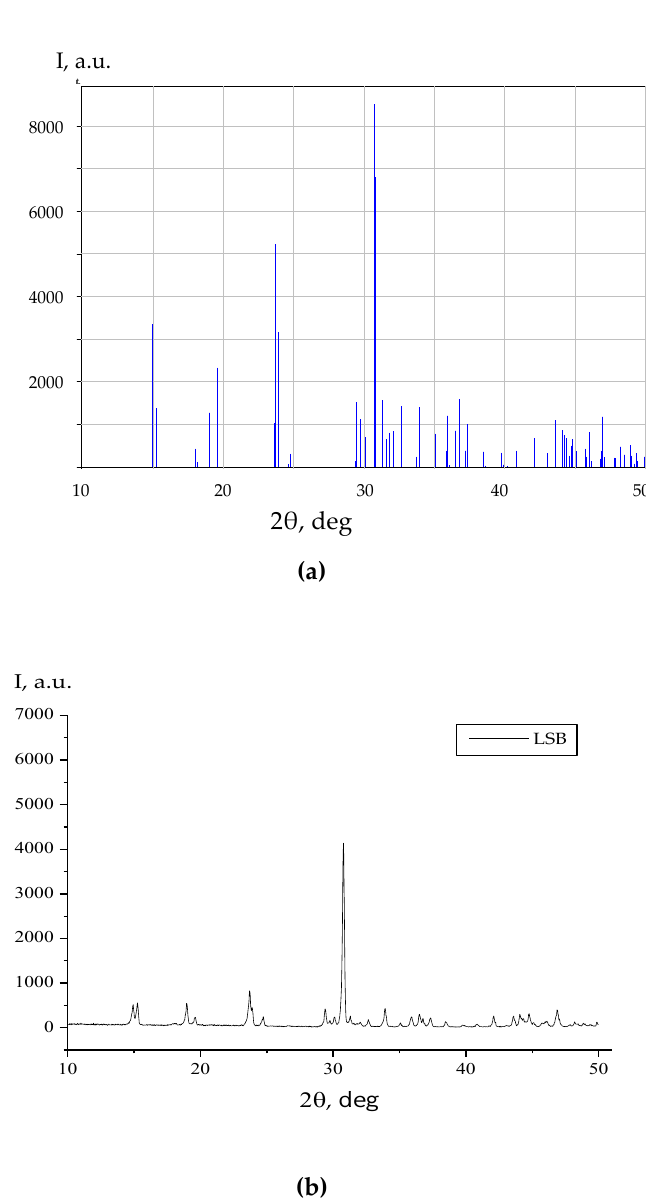
Figure 10. ( a ) Theoretical and ( b ) experimental diffraction patterns for the α - LaSc 3 (BO 3 ) 4 structure (space group C 2/ c ).